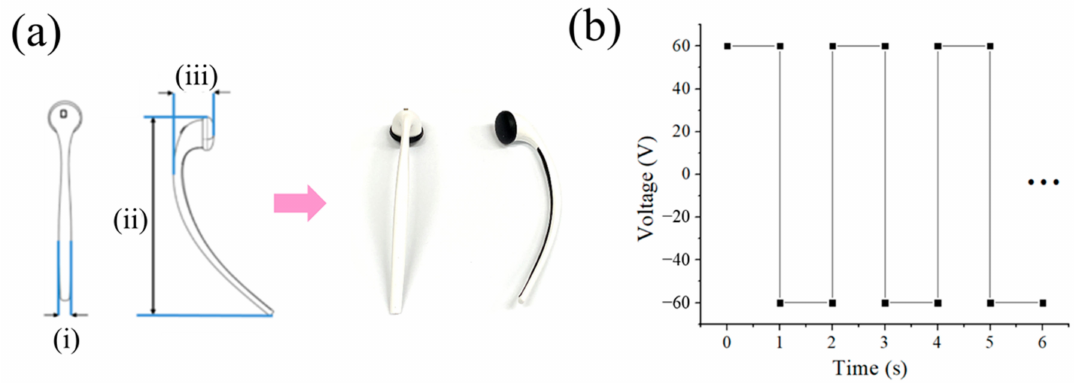
Figure 6. Galvanic ionic device for current flow. ( a ) Designed ionic device at different scales: ( i ) length: 6.00, ( ii ) length: 99.50, and ( iii ) length: 20.10. The arrow indicates the actual manufactured product image. ( b ) Continuous waveform from the real designed portable ionic device.